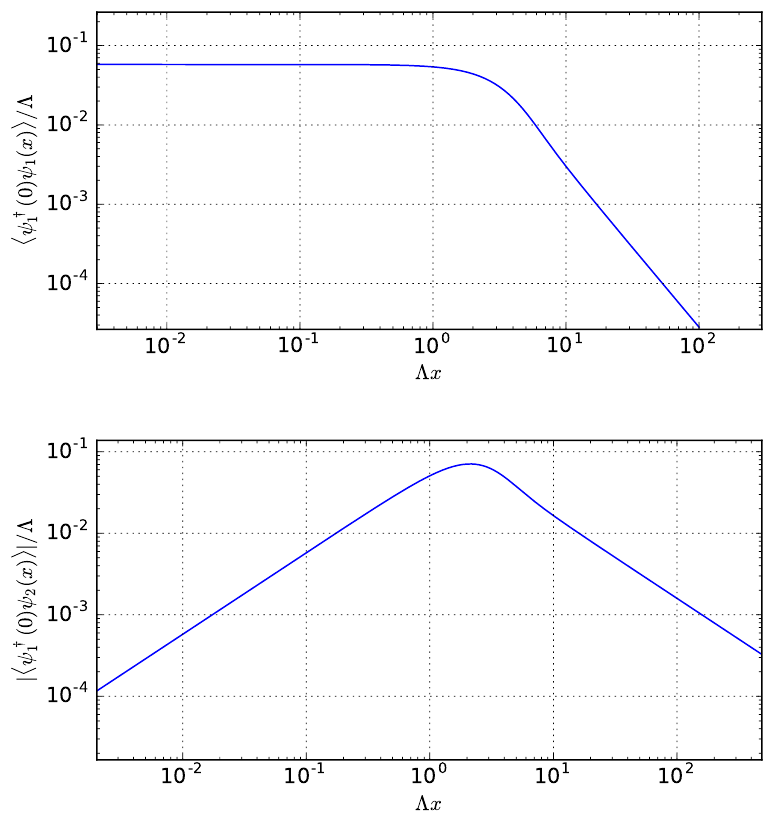
Figure 13 . Correlation functions h y and computed for a cMERA de(cid:12)ned by (cid:18) ( k ) as in (4.18) for j = 0. Notice the existence of two clearly di(cid:11)erent regimes delimited by (cid:3) x (cid:24)